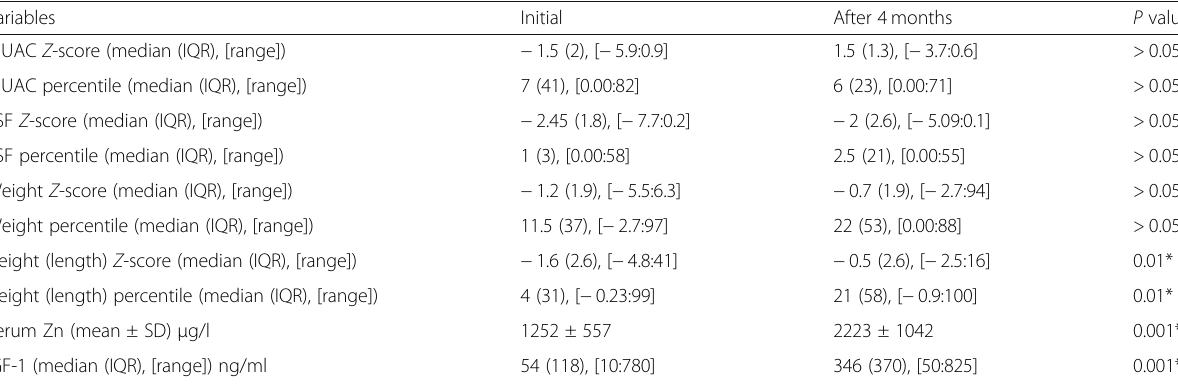
Table 4 Anthropometric measurements, serum zinc, and IGF 1 of the cholestatic patients before and after zinc supplementation Variables Initial After 4 months P